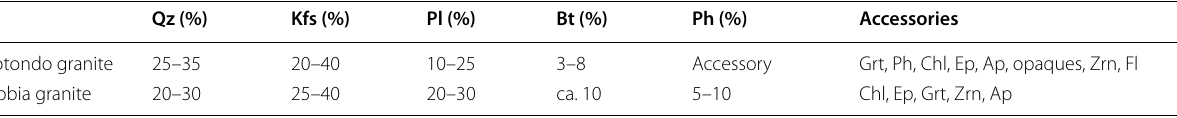
Table 1 Composition of the Rotondo and Fibbia granites based on Hafner (1958), Labhart (2005) and Steck (1976) Qz (%) Kfs (%) Pl (%) Bt (%) Ph (%) Accessories Rotondo Mineral abbreviations according to Whitney and Evans (2010)